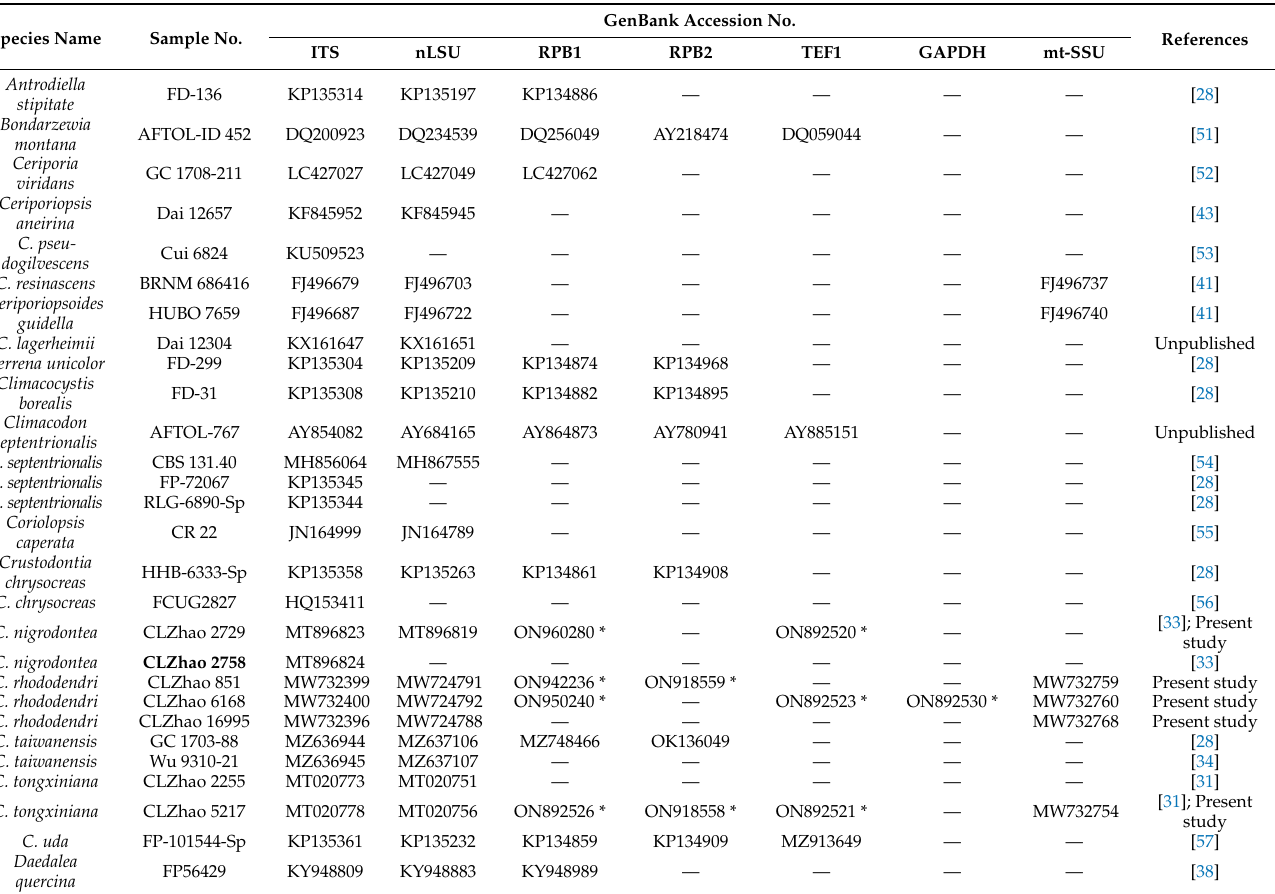
Table 2. Names, voucher codes, and corresponding GenBank accession numbers of sequences used in this